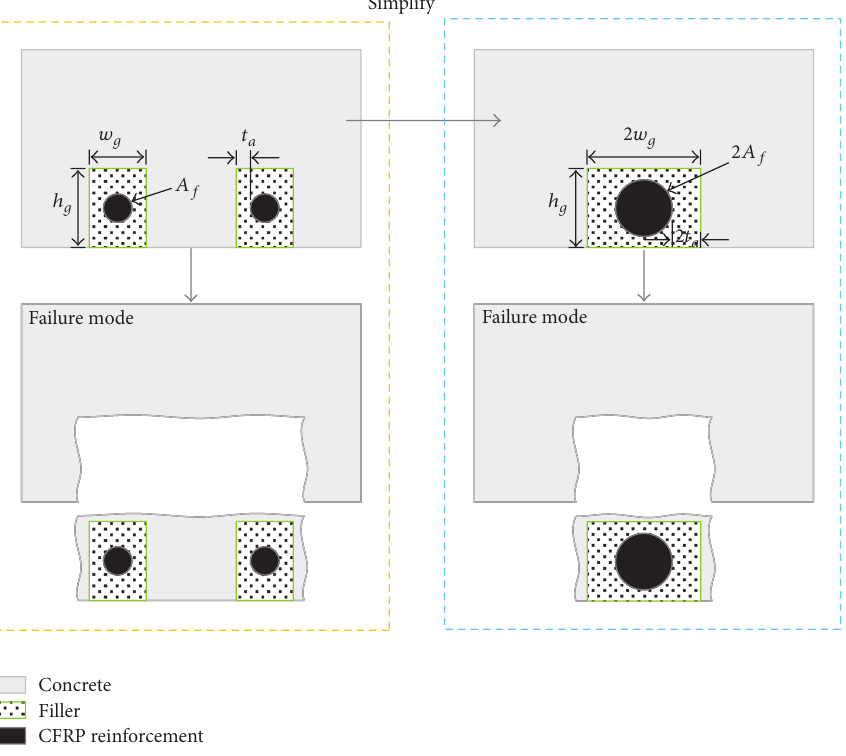
Figure 7: Simplification of failure mode of 2-line reinforcement [bond model II-2].